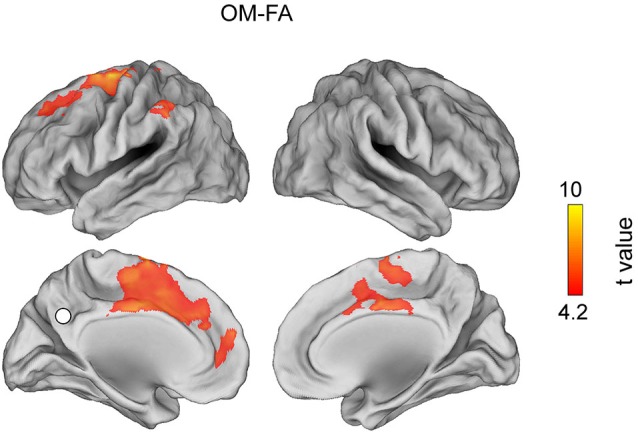
T map for the contrast OM meditation vs. FA meditation in the alpha band (p < 0.01, corrected value).